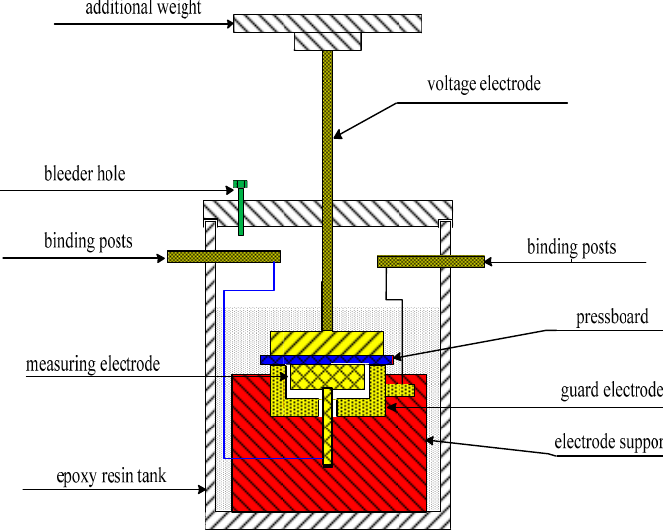
Figure 3. Schematic diagram of three-electrode test cell.